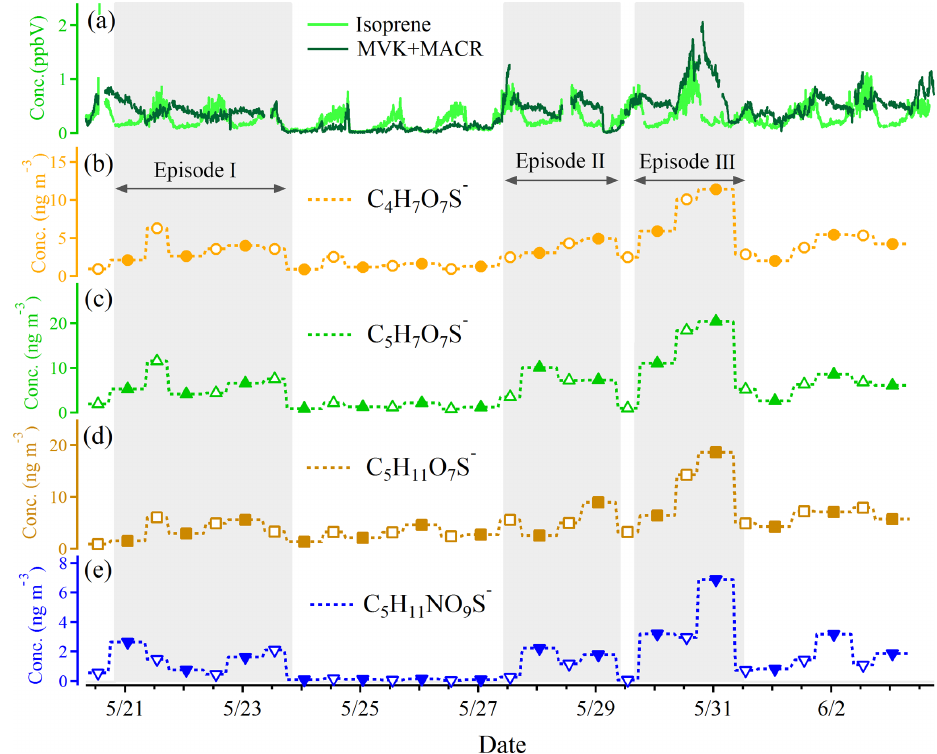
Figure 7. Time series of (a) isoprene and MVK + MACR, the isoprene OSs (b) C 4 H 7 O 7 S − , (c) C 5 H 7 O 7 S − , and (d) C 5 H 11 O 7 S − , and the (e) NOSs (C 5 H 11 NO 9 S − ). The pollution episodes are marked by gray shading. MVK and MACR are the abbreviations for methyl vinyl ketone and methacrolein,